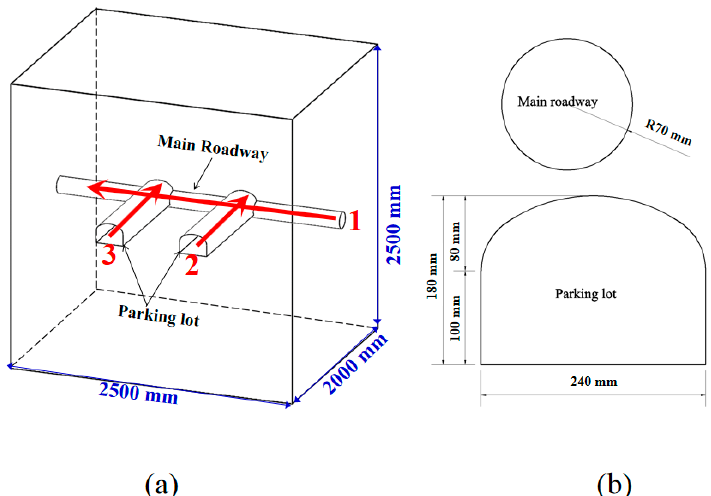
Figure 8. Model test design drawing (the red arrow is the excavation direction, and the number is the excavation sequence). ( a ) Schematic diagram of caverns layout in model test; ( b ) Schematic diagram of cavern section size in model test.